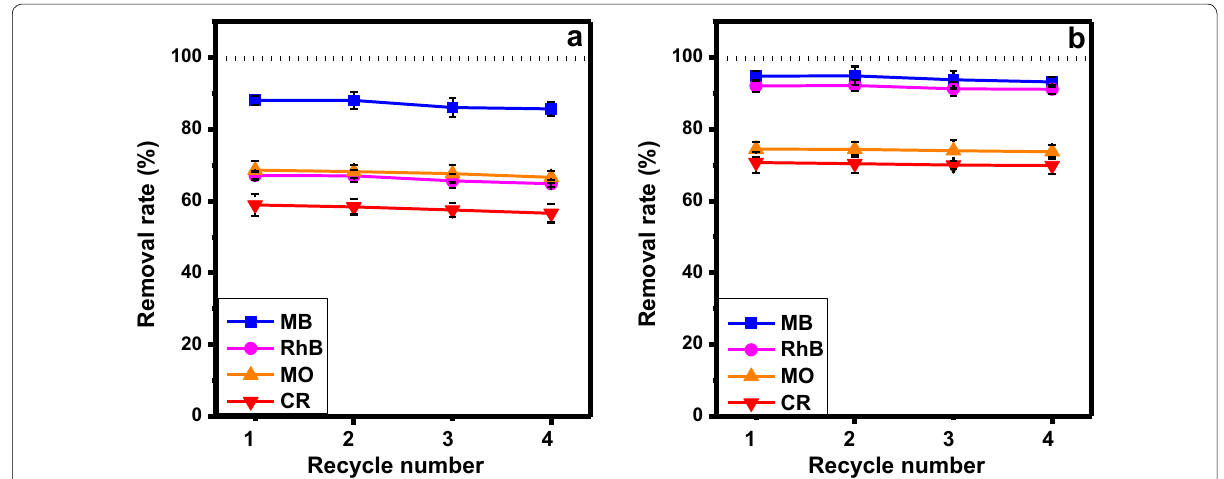
Fig. 10 The dye removal rate obtained for the GC_15 composite hydrogel column in the reuse process using a direct filtration and b filtration after 24 h of